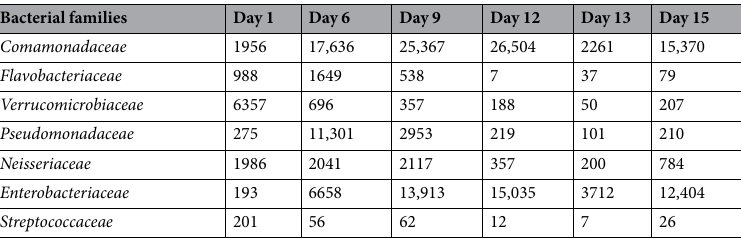
Bacterial families